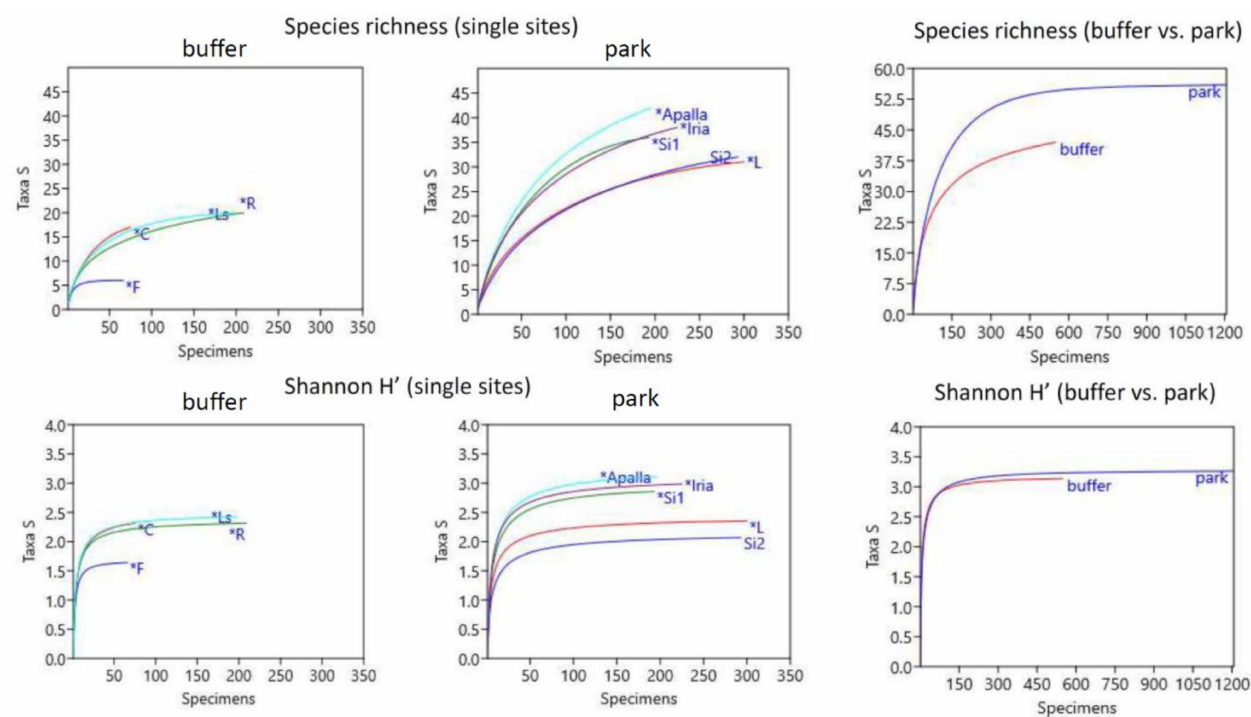
Figure 3. Rarefaction curves for species richness and Shannon-Wiener diversity H (cid:48) index. On the ( left ): comparison among single sites in buffer zone ( left ) and national Park ( middle ); On the ( right ): comparisons between total communities (buffer zone vs. national park).